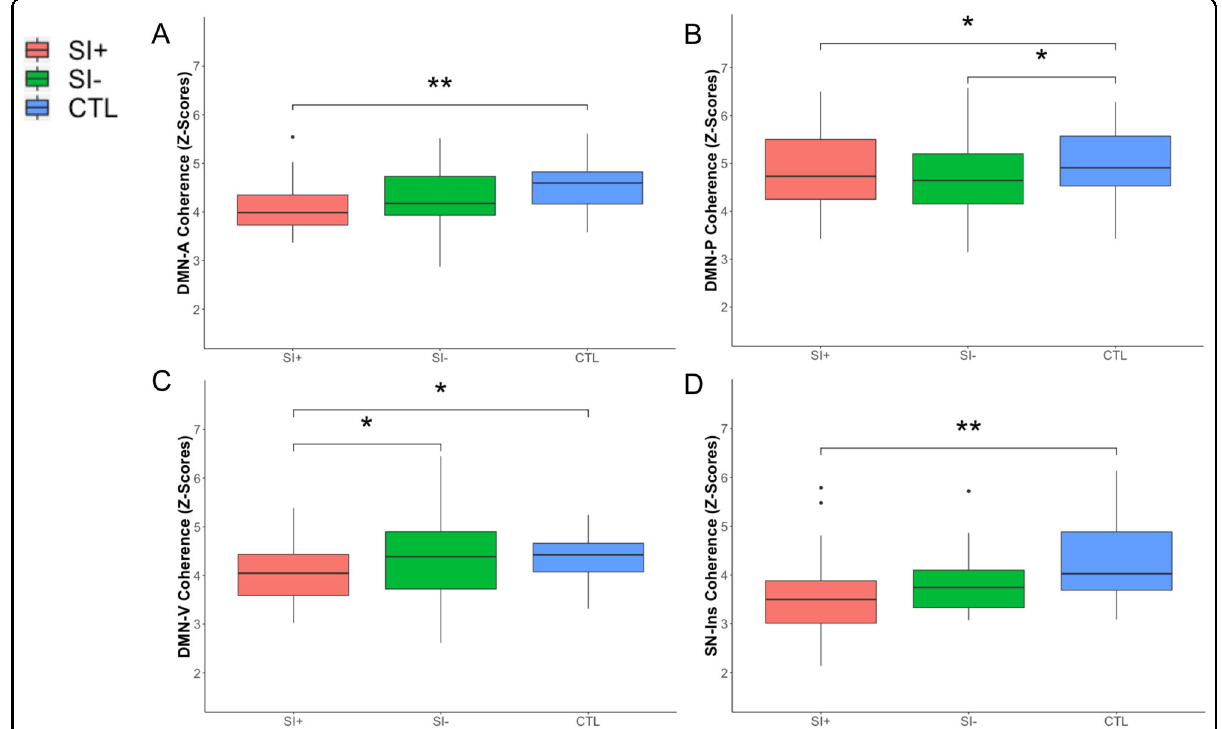
Fig. 2 Network coherence patterns associated with suicidal ideation. SI + exhibited signi fi cantly lower network coherence in DMN-A ( a ), DMN-P ( b ), DMN-V ( c ), SN-Ins ( d ) compared to CTL. SI + exhibited signi fi cantly lower network coherence in DMN-V compared to SI − ( c ). SI − exhibited signi fi cantly lower network coherence in DMN-P compared to CTL ( b ). For the purposes of visualization, all box plots depict raw data without adjustment of covariates. See Table 2 and S1 for more details. DMN-A anterior default mode network, DMN-P posterior default mode network, DMN-V ventral default mode network, SI suicidal ideation, CTL healthy controls, SN-Ins Salience Network-Insula. * p < 0.05, ** p < 0.01